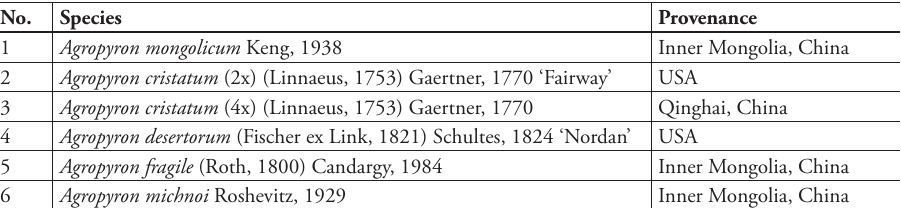
Table 1. Plant materials used in the study. No.